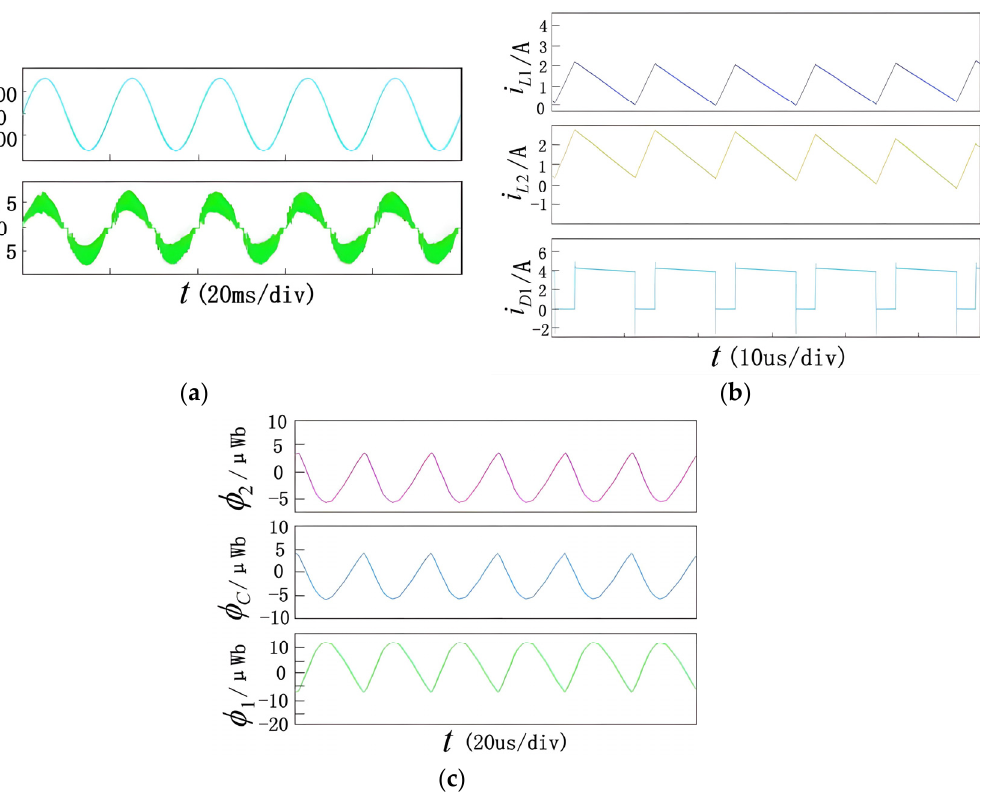
Figure 8. Simulation results of Cuk circuit with integrated magnetics. ( a ) Waveforms of v in and i in. ( b ) Waveforms of i L 1 , i L 2 and current i D 1. ( c ) Waveforms of φ 1 , φ 2 and φ 3 . ( b ) Waveforms of i L 1 , i L 2 and current i D 1. ( c ) Waveforms of ϕ 1 , ϕ 2 and ϕ 3